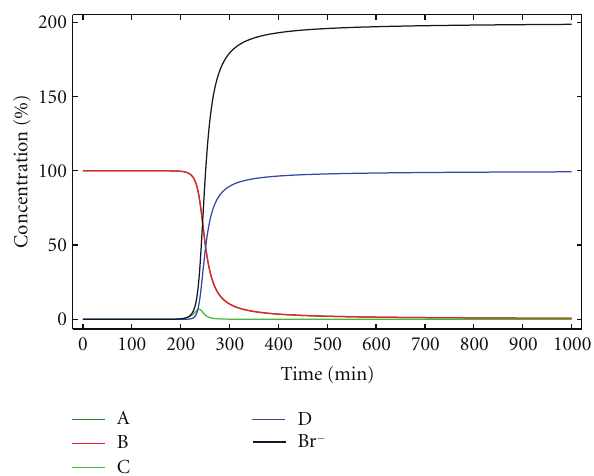
Figure 9: Concentration of the reactants, products, and reaction intermediates versus time for kinetic model 5. [A] 0 = [B] 0 = 0.005 M, [Br − ] 0 = 10 − 12 M, k 1 c = 4000M − 1 min − 1 and k 2 c = 200M − 1 min − 1 .